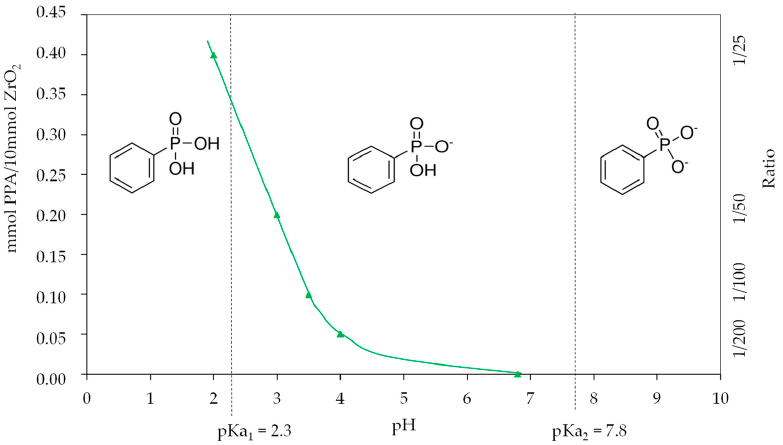
Figure 7. pH variation as a function of the concentration of PPA in solution and predominance of phenylphosphonate species as a function of pH.